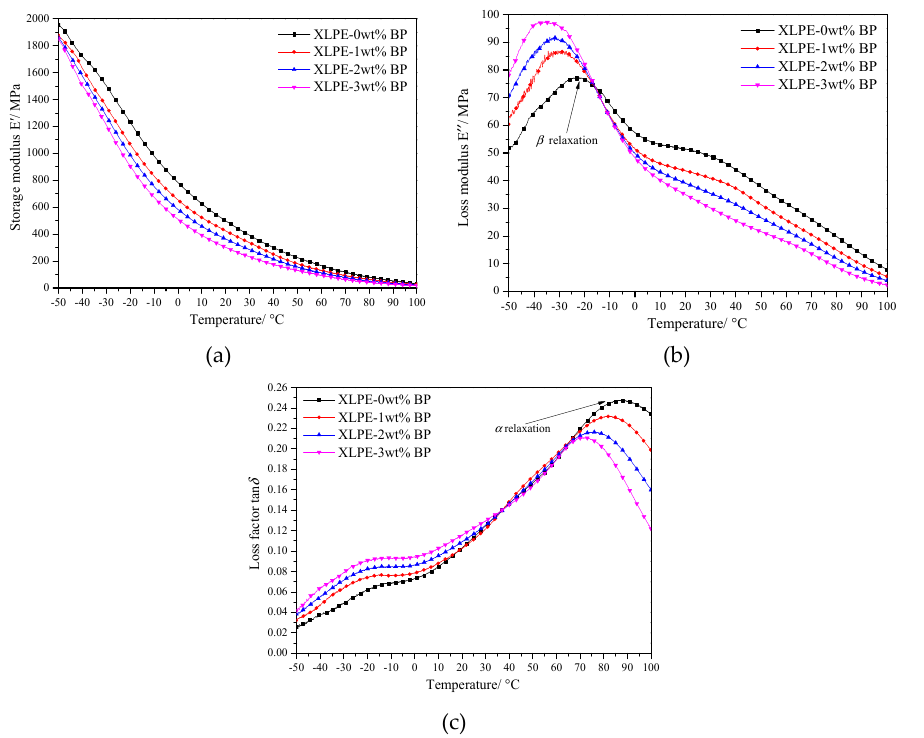
Figure 5. Dynamic relaxation temperature spectra: ( a ) storage modulus E ’; ( b ) loss modulus E ”, and ( c ) dissipation factor tan δ .